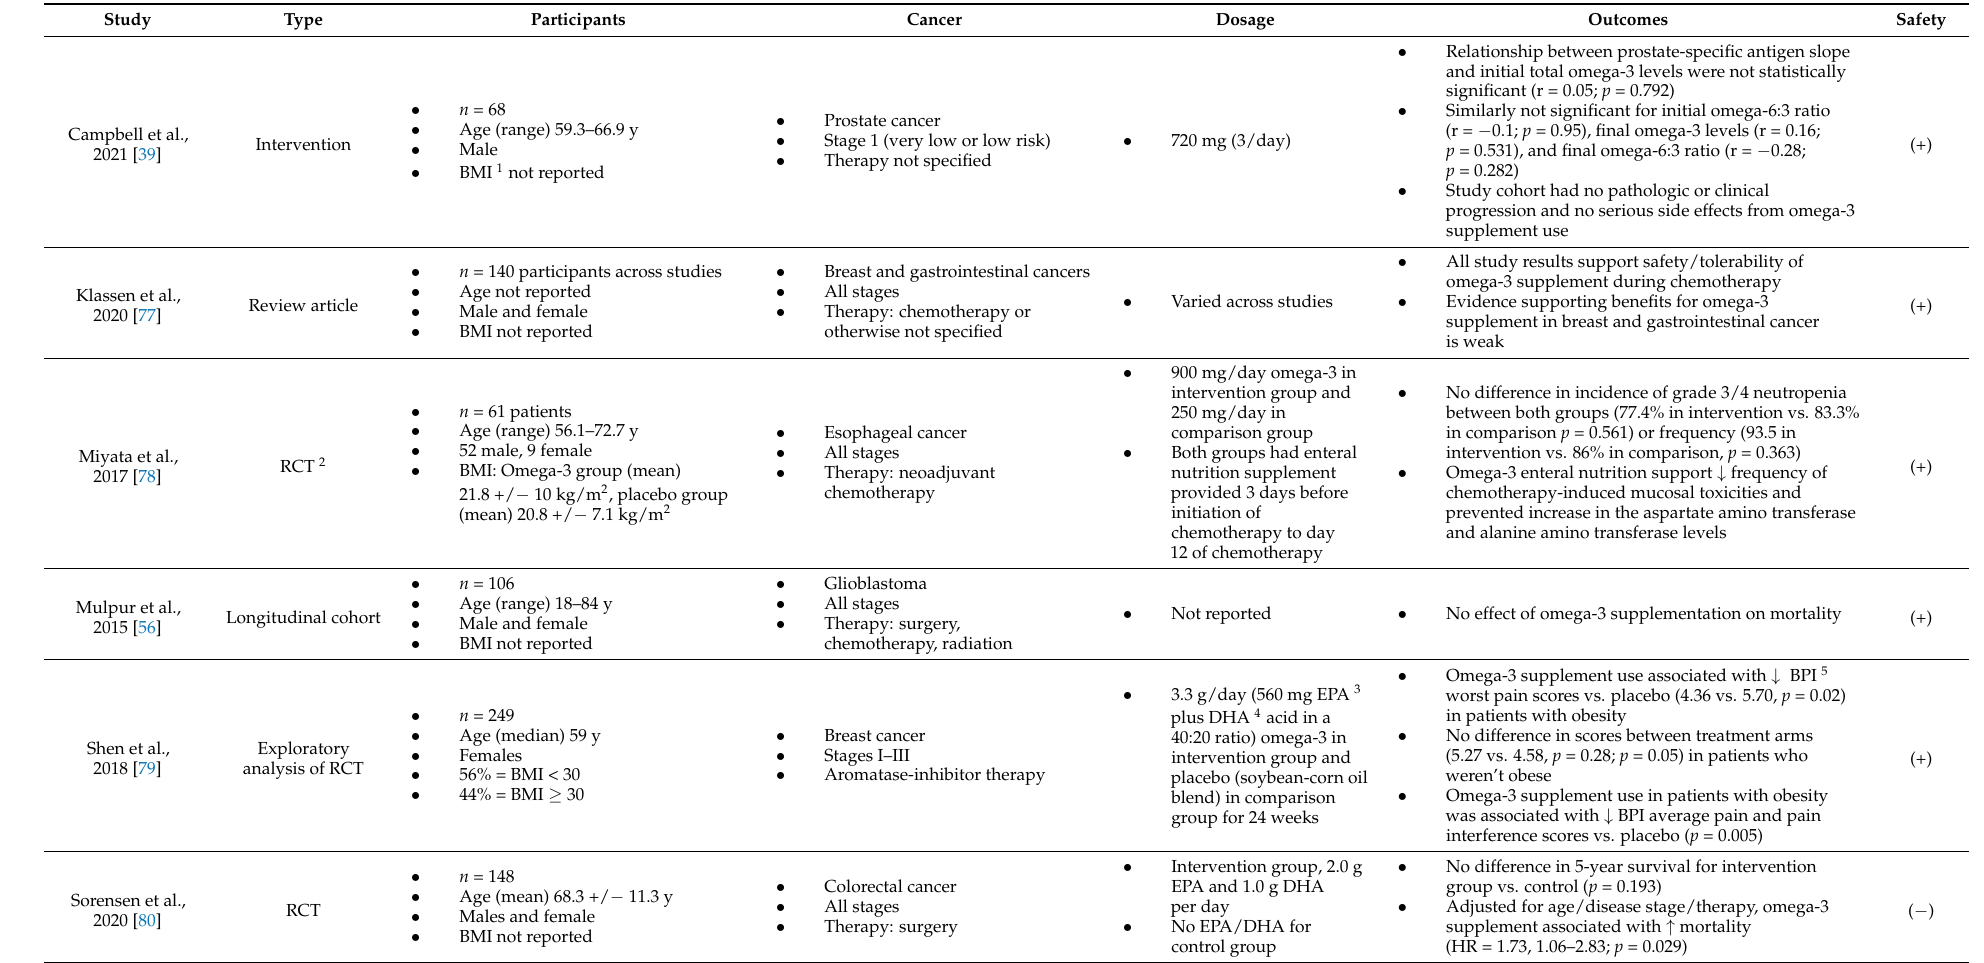
Table 4. Safety of omega-3 fatty acid supplements for patients with